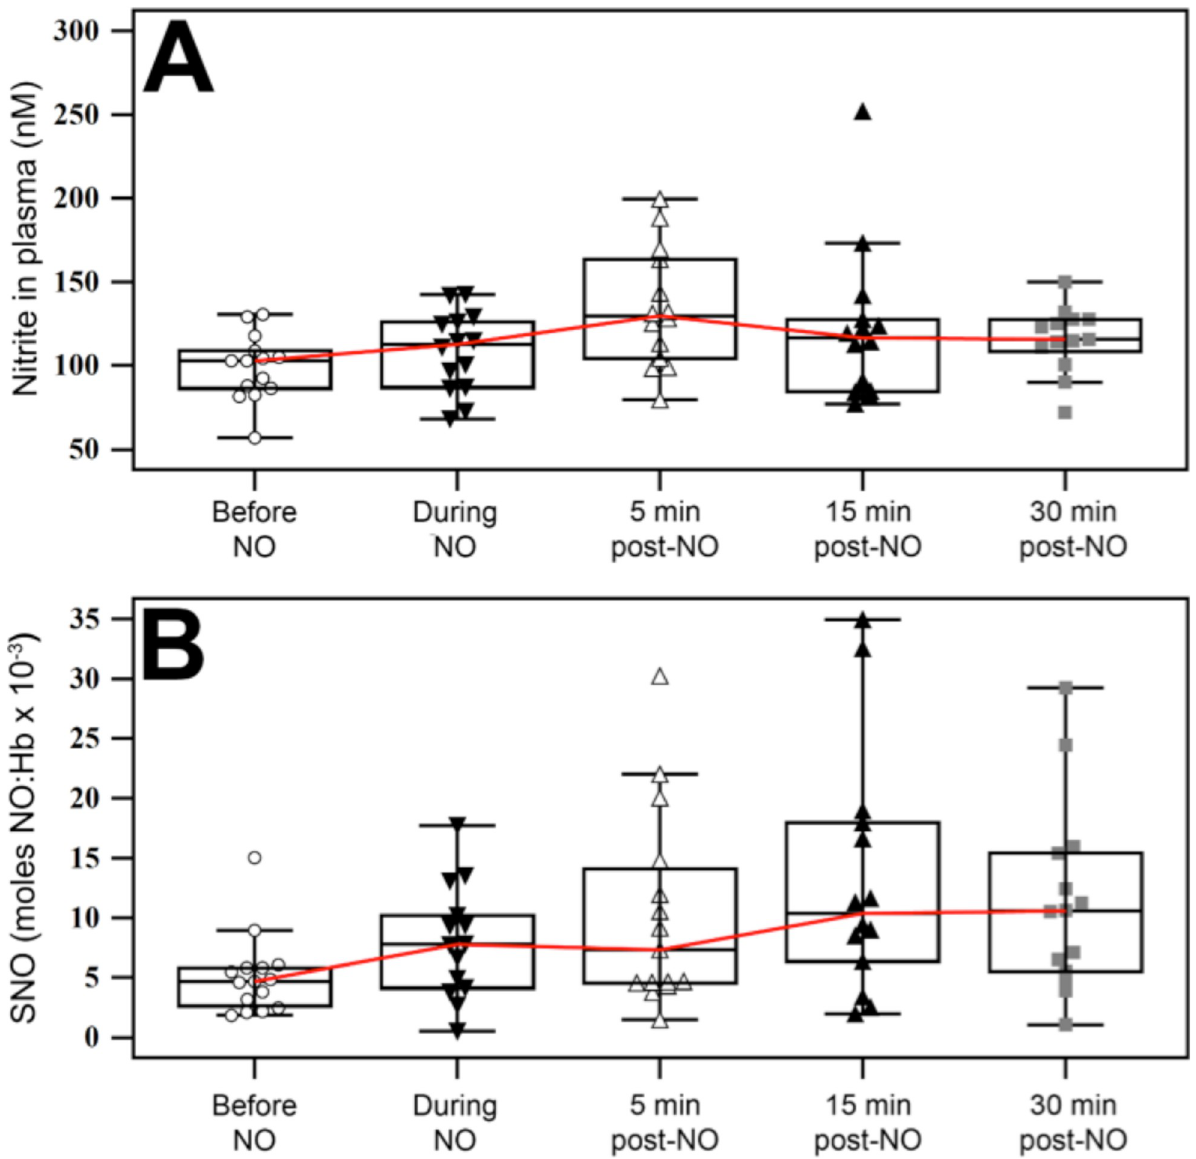
Fig 1. Box plots of plasma nitrite and RBC SNO-Hb before, during and after NO inhalation. The red line connects the median values at the different time